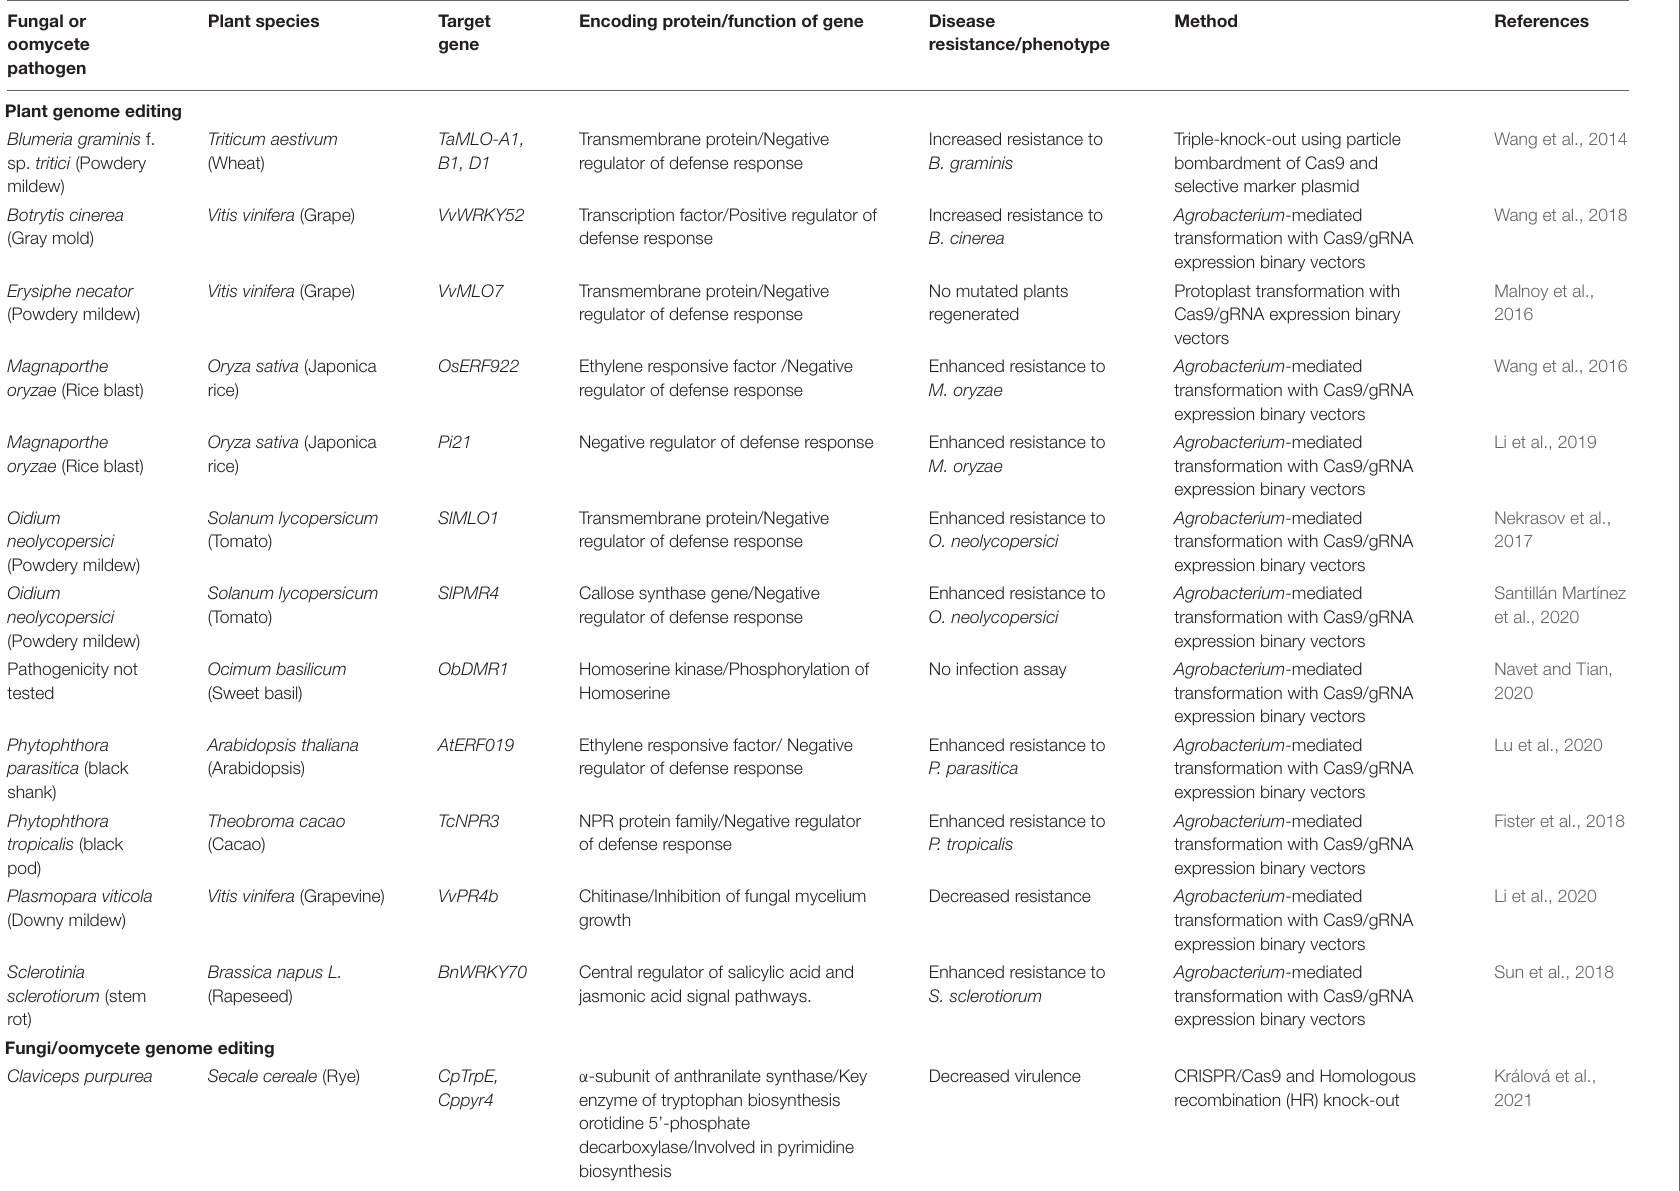
TABLE 1 | Applications of CRISPR/Cas9 and CRISPR/Cpf1 systems for plant resistance to fungal and oomycete pathogens. Fungal or